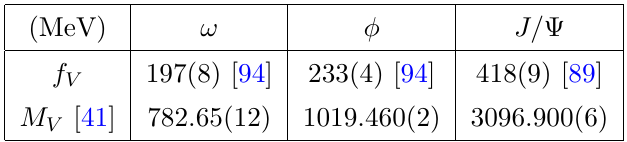
Table 10 . Decay constants and masses for ! , (cid:30) and J= vector